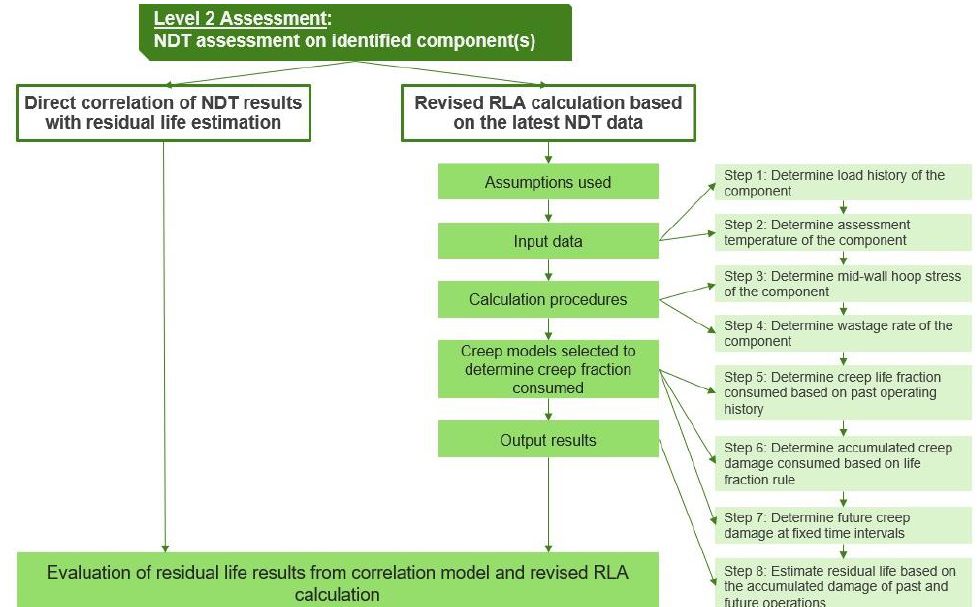
Figure 3. Flow chart on the steps for L2 approach in creep RLA.